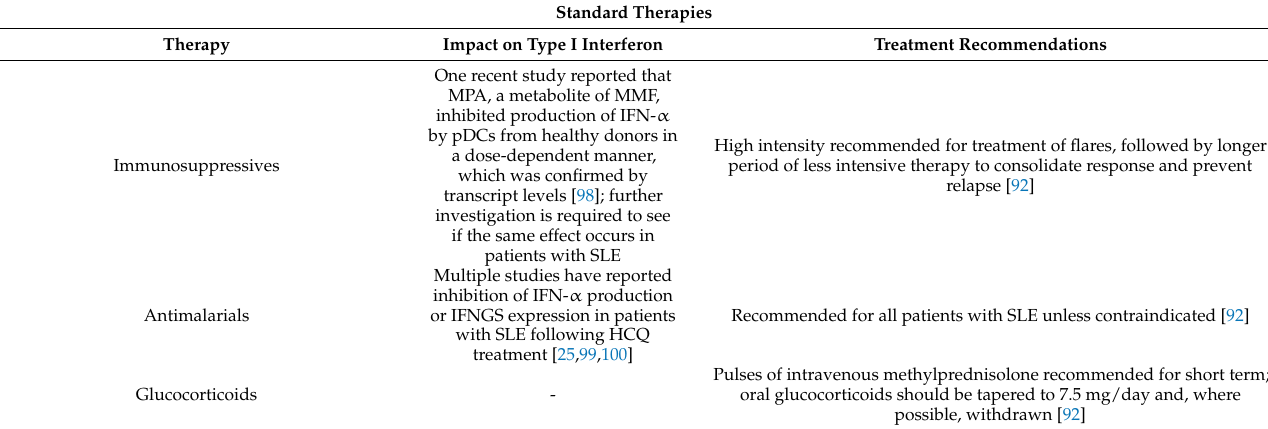
Table 1. Summary of approved and developmental therapeutics for patients with SLE and their direct/indirect effects on type I interferon